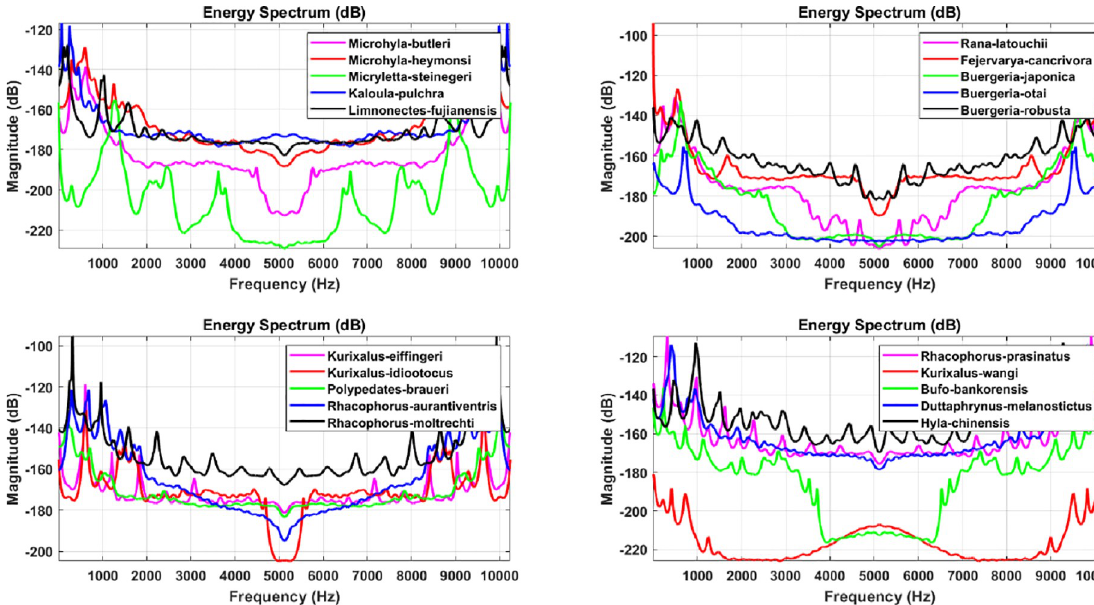
Fig 9. The spectrum diagram of anuran bioacoustic features filtered through the LPC algorithm with P coefficient equal to 60, including Microhyla butleri , Microhyla heymonsi , Micryletta steinegeri , Kaloula pulchra , Limnonectes fujianensis , Rana latouchii , Fejervarya cancrivora , Buergeria japonica , Buergeria otai , Buergeria robusta , Kurixalus eiffingeri , Kurixalus idiootocus , Polypedates braueri , Rhacophorus aurantiventris , Rhacophorus moltrechti , Rhacophorus prasinatus , Khirixalus wangi , Bufo bankorensis , Duttaphrynus melanostictus and Hyla chinensis .